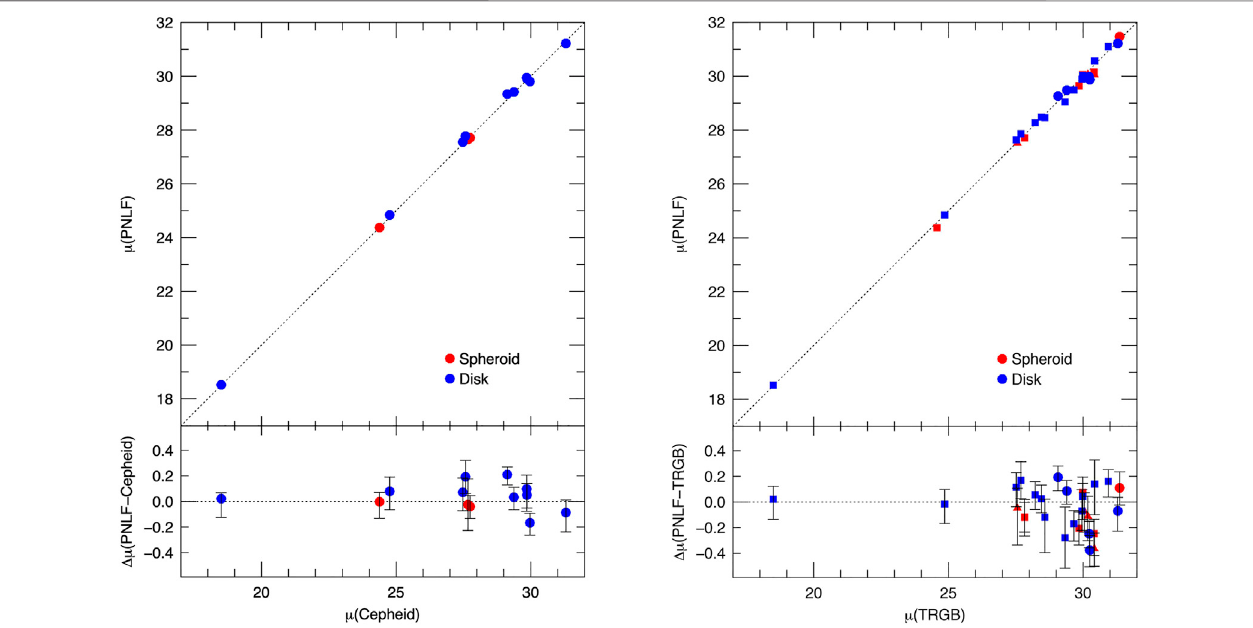
FIGURE5| Left: ComparisonofPNLFandCepheiddistancesfor13luminousgalaxies,assuming M *= − 4.53.Thetoppanelshowstheone-to-relation;thebottom panel displays the difference in the derived distance moduli. There is no evidence for any systematic behavior, and the scatter is consistent with the internal errors of the methods. Right: Comparison of the PNLF with TRGB distances. The circles are measurements from the Carnegie-Chicago Hubble program (Beaton et al., 2016), the squares represent values taken from Anand et al. (2021), and the triangles come from other sources. Here the scatter is larger than the internal errors, suggesting one or both methods have additional